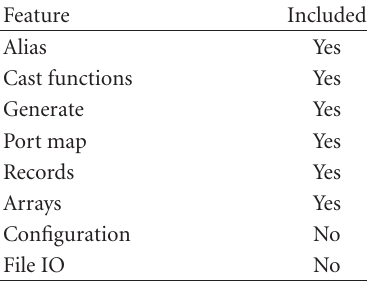
Table 2: V2SC + wrapper